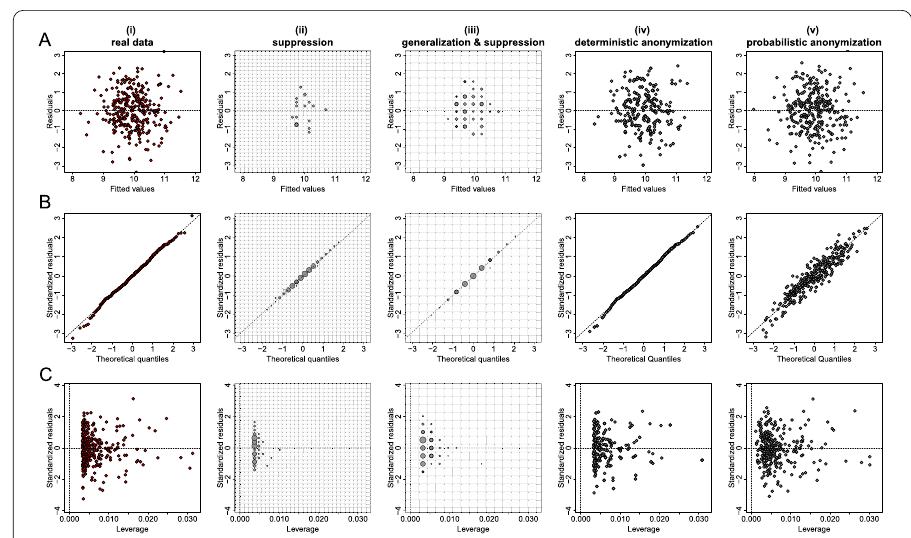
Figure 21 The performance of the techniques applied in a sample of 300 observations. From top to bottom we demonstrate the residuals vs fitted values plots ( A ), normal QQ plots ( B ), and standardized residuals vs leverage plots ( C ) for real regression outcomes (i), suppressed regression outcomes (ii), generalized and suppressed regression outcomes (iii), deterministically anonymized regression outcomes (iv) and probabilistic anonymized regression outcomes